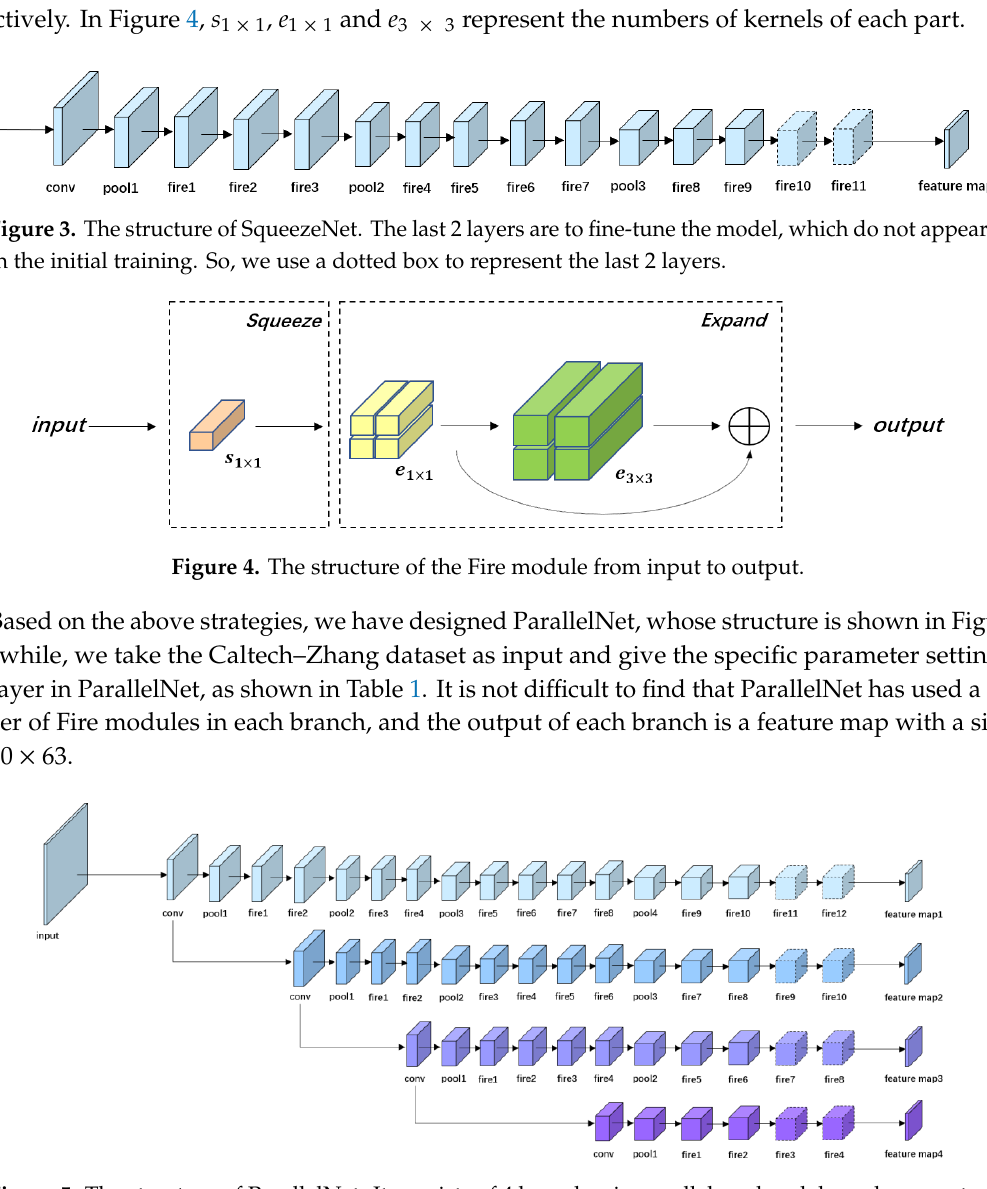
Figure 5. The structure of ParallelNet. It consists of 4 branches in parallel, and each branch generates a feature map of equal size. In the follow-up process, the 4 feature maps will be fused into one feature map.